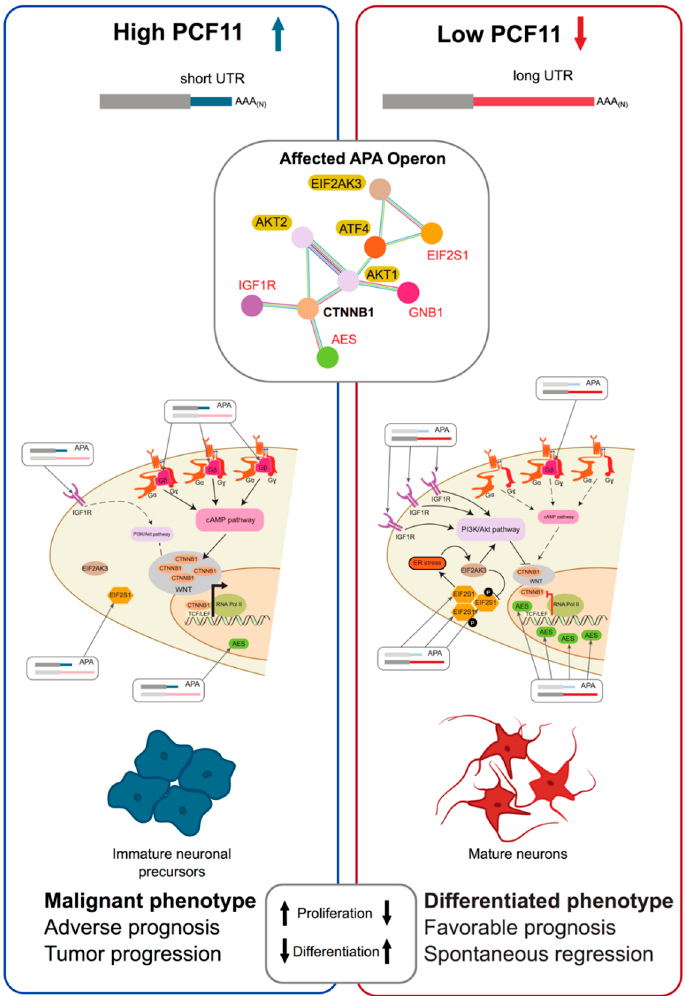
Figure 3. PCF11-directed APA drives neuroblastoma. An example of APA perturbation eliciting deleterious cellular programs. PCF11 is among the top drivers of APA [13], compare TREND-DB (http: // shiny.imbei.uni-mainz.de:3838 / trend-db / ). Postnatal down-regulation results in general 3 (cid:48) UTR lengthening required to induce neurodi ff erentiation. PCF11-directed APA targets insulin like growth factor 1 receptor (IGF1R), eukaryotic translation initiation factor 2 subunit alpha (EIF2S1), TLE family member 5, transcriptional modulator (AES, TLE5) and G protein subunit beta 1 (GNB1), which constitute a highly enriched APA-operon (Red; String-DB), converging on WNT signalling via beta-catenin (CTNNB1; bold). This alters downstream IGF1R, phosphatidylinositol-4,5-bisphosphate 3-kinase (PI3K) / AKT serine / threonine kinase and endoplasmic reticulum (ER) stress response signalling pathways (highlighted), ultimately modulating cell cycle progression, proliferation, apoptosis and neuronal di ff erentiation. Sustained high level PCF11 expression arrests neuronal precursors in an immature state, giving rise to neuroblastomas. Low-level PCF11 in neuroblastoma associates with favourable outcome and spontaneous tumour regression, while high-level PCF1 associates with adverse outcome and tumour progression (other genes indicated eukaryotic translation initiation factor 2 alpha kinase 3 (EIF2AK3), AKT serine / threonine kinase 2 and 2 (AKT2 and 2), activating transcription factor 4 (ATF4), eukaryotic translation initiation factor 2 subunit alpha (EIF2S1), catenin beta 1 (CTNNB1); figure modified after A. Ogorodnikov, Dissertation, Johannes Gutenberg University Mainz, 2017 “Massive RNAi screening dentifies key drivers of transcriptome 3 (cid:48) end diversity with a direct role in neuroblastoma tumor